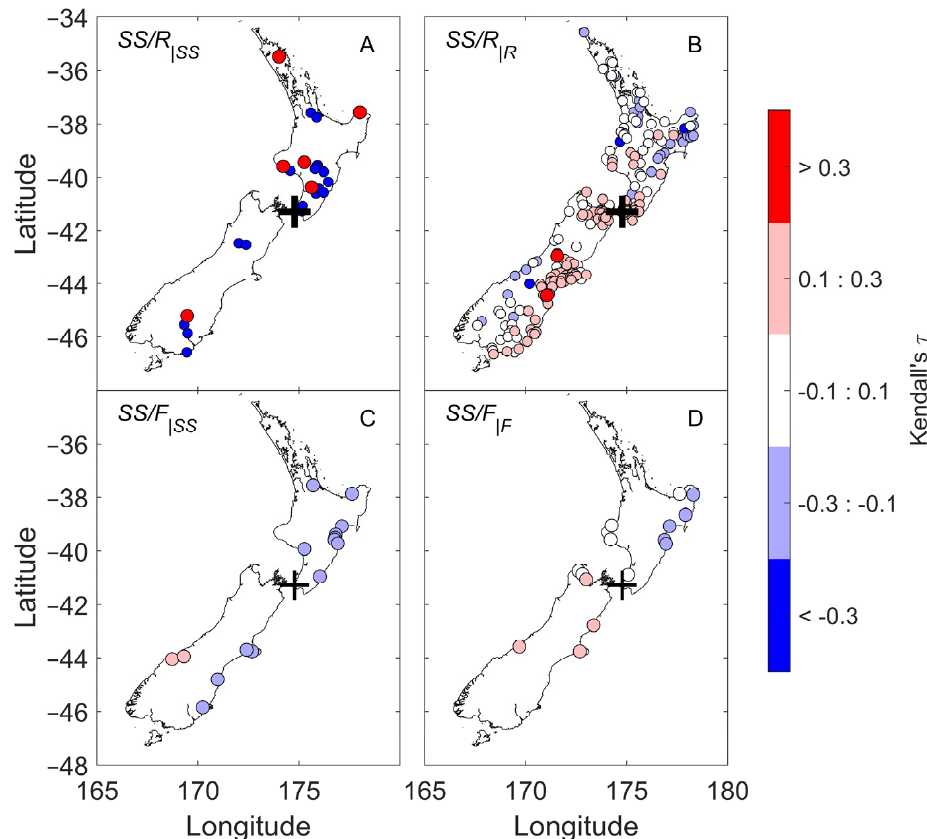
Figure 6. Kendall’s rank correlation coefficient τ (color scale) calculated between skew-surge measured at Wellington and individual rainfall and river-flow records. ( A ) τ for skew-surge and rainfall, with rainfall conditional on extreme skew-surge; ( B ) τ for skew-surge and rainfall, with skew-surge conditional on extreme rainfall, ( C ) τ for skew-surge and river-flow, with river-flow conditional on extreme skew-surge, ( D ) τ for skew-surge and river-flow, with skew-surge conditional on extreme river-flow.